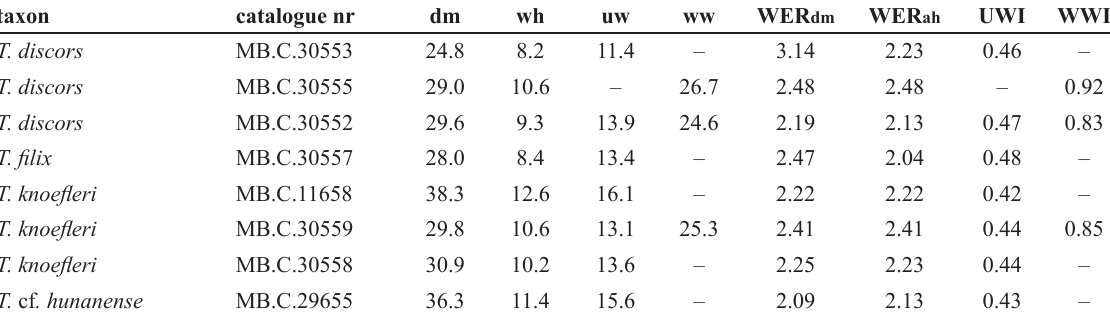
Table 12. Conch measurements (in mm), ratios and rates of coiled conch parts of Trilacinoceras Sweet, 1958.